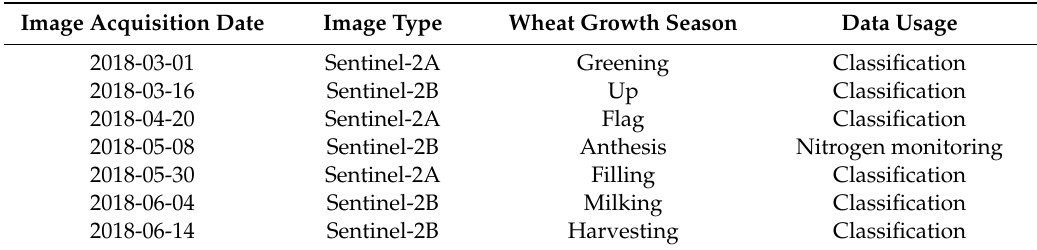
Table 3. Acquired remote sensing imagery types and time, as well as the winter wheat growth